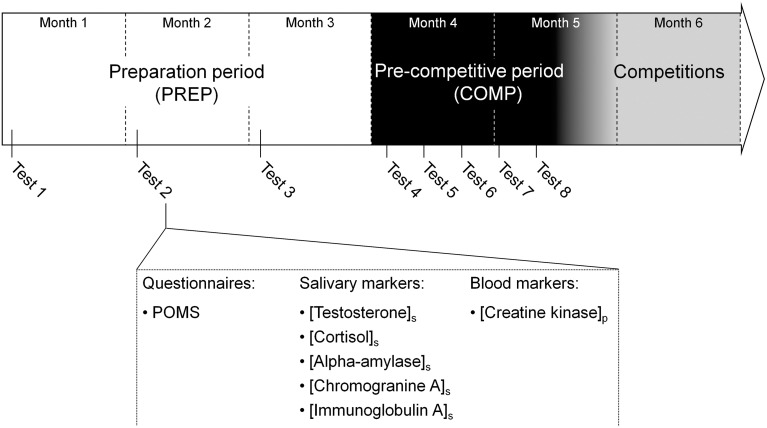
Overview of the experimental design. A total of eight tests sessions were spread over the 5 months prior to the international competition period. The first three tests were performed during the first week of 3 month of the preparation period (PREP) consisted of high volume and low intensity contents. During the pre-competitive period (COMP) characterized by low volume and high intensity training, identical tests sessions were performed every Monday during 5 weeks. Each test session included a Profile Of Mood State (POMS) questionnaire, salivary and blood samples to assess total mood disturbance, salivary concentration of testsosterone, cortisol, alpha-amylase, immunoglobulin A and chromogranin A and plasma creatine kinase activity.